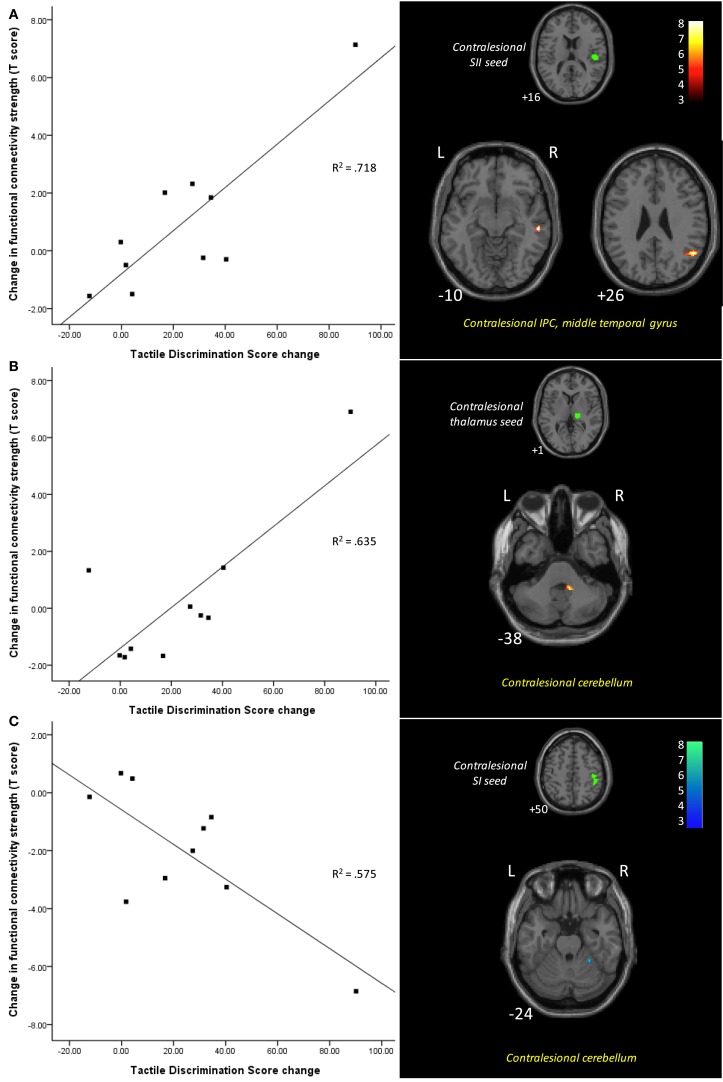
Functional connectivity differences between 1 and 6 months post-stroke associated with changes in tactile discrimination test (TDT) scores. Scatter plots illustrate change in TDT score plotted against the difference between the two time points in connectivity strength between the seed and the cluster (shown in images on the right), for each individual. Improvement in TDT scores was associated with (A) greater functional connectivity at 6 months between the contralesional SII seed and clusters in the contralesional inferior parietal cortex and contralesional middle temporal gyrus; (B) greater functional connectivity at 6 months between the contralesional thalamus seed and a cluster in contralesional cerebellum; and (C) less functional connectivity at 6 months between the contralesional SI seed and contralesional cerebellum. Images are displayed in neurological convention (subject’s left is displayed on image left). The left hemisphere represents the ipsilesional hemisphere – images of patients with right hemisphere lesions were flipped such that all infarcts are represented in the left hemisphere. Slice numbers represent axial slice position in Montreal Neurological Institute (MNI) space. Color scale represents Z-values of functionally connected clusters associated with TDT score change. SI, primary somatosensory cortex; SII, secondary somatosensory cortex; IPC, inferior parietal cortex. Analyses are based on contrast maps with an individual voxel height threshold level of p < 0.001. Only clusters with p-values <0.05 (false discovery rate, FDR, corrected) are reported as significant and displayed.